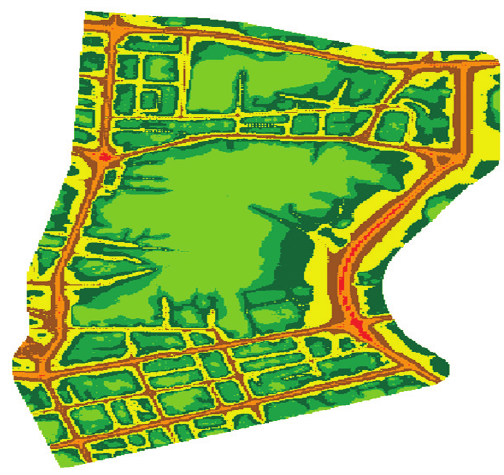
Fig. 11. Modelled noise level of segment 3 of the central part of Panevėžys city by